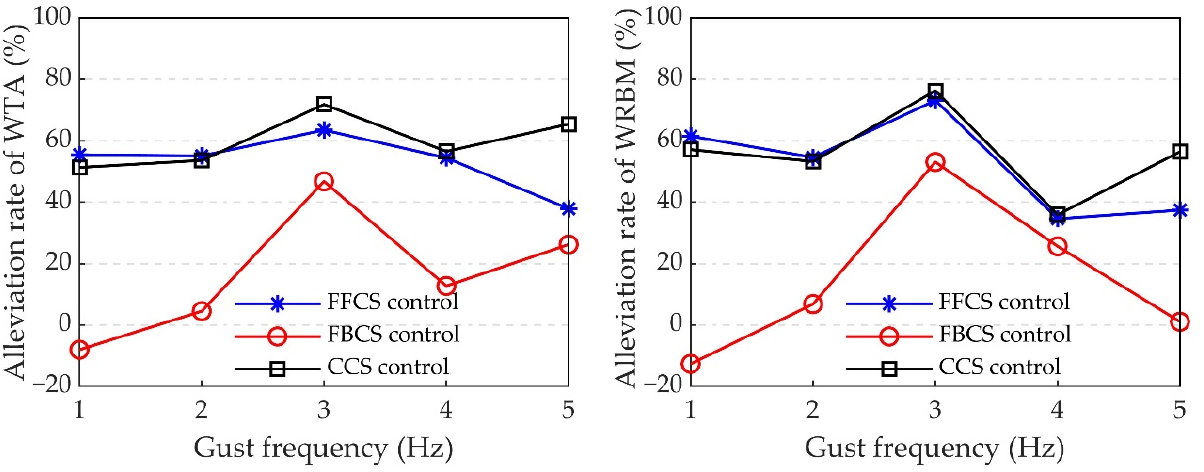
Figure 19. Alleviation effect of each control system under different gust frequencies (20.0 m/s).